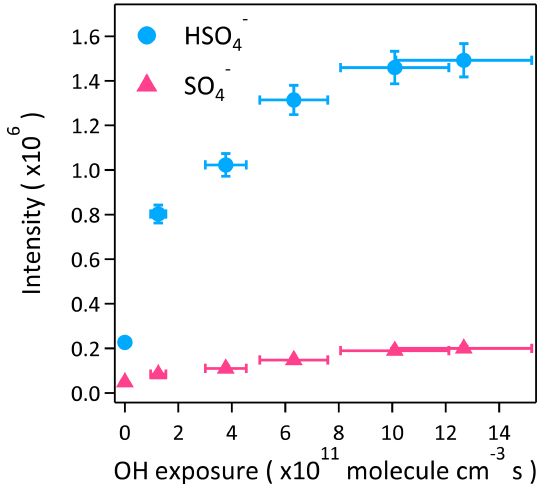
Figure 2. The kinetic evolution of HSO 4 − and SO 4 − as a function of OH exposure during the heterogeneous OH oxidation of sodium methyl sulfate. The small uncertainty in ion intensity measurement for SO 4 − is not visualized in the figure.